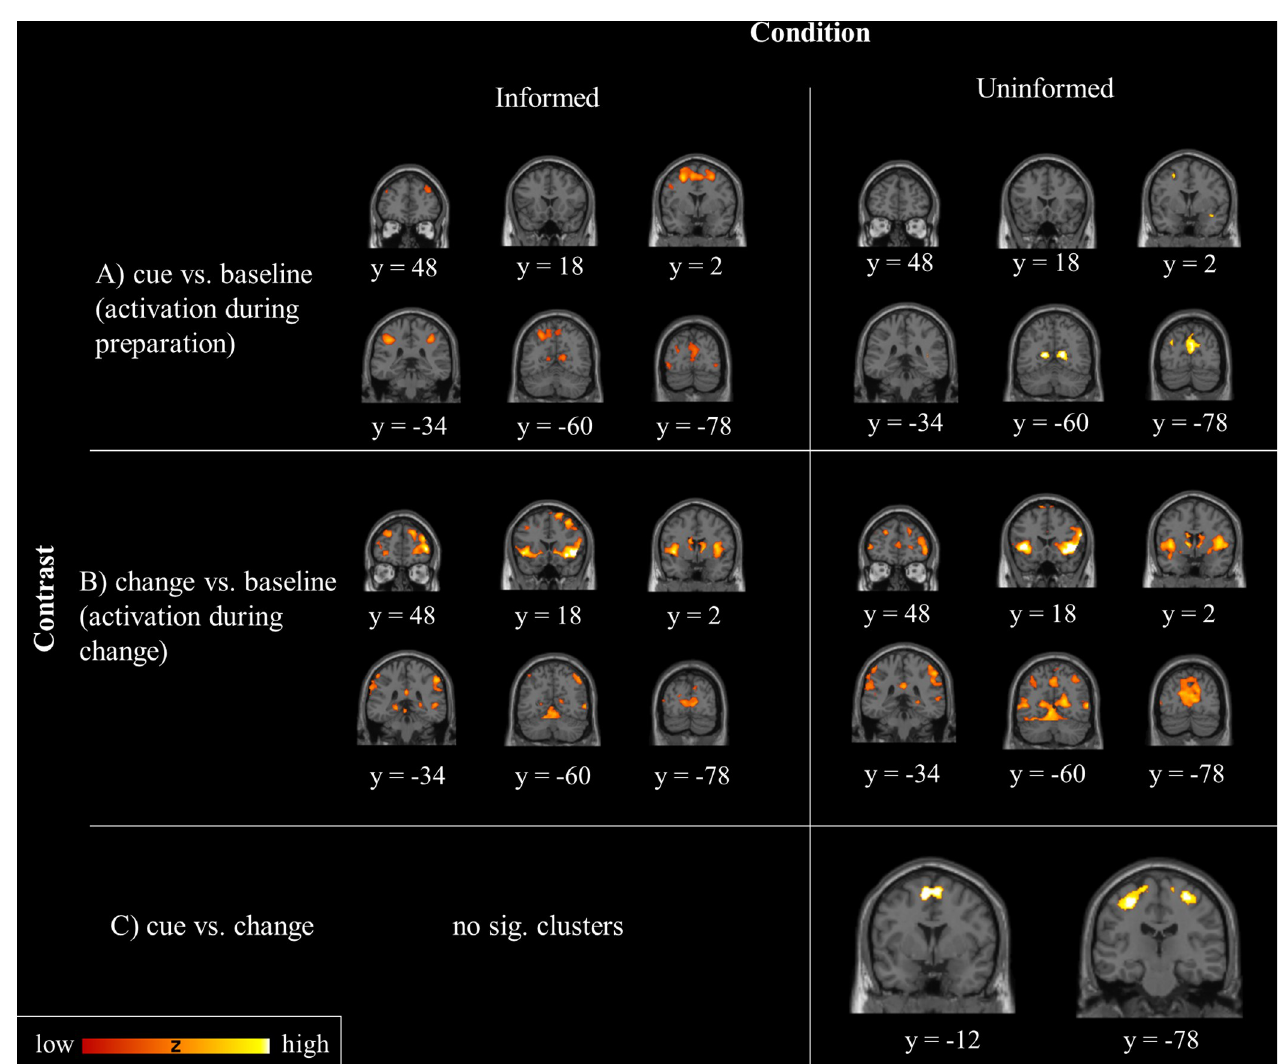
Fig 2. Activation during cue and change-signal presentation in the informed and uninformed condition. Rows present activation for the contrasts: A) cue vs. baseline, B) change vs. baseline, C) cue vs. change for the informed (left column) and uninformed (right column) condition. More reddish blobs represent lower Z values, while more yellowish blobs represent higher Z values. Slices are presented from rostral to caudal with y-coordinates assigned to MNI space. All activations were uncorrected on voxel level ( p < 0.0001, spatial extent threshold of 20 adjacent